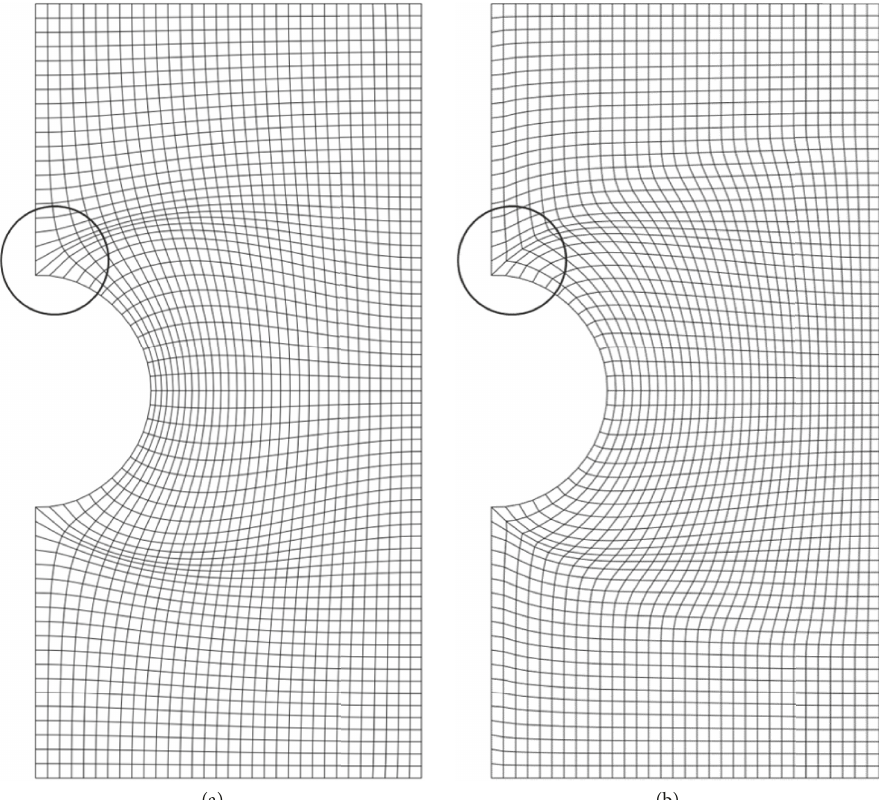
Figure 1: Grids generated without and with curvature control, (a) with no curvature control and (b) with curvature